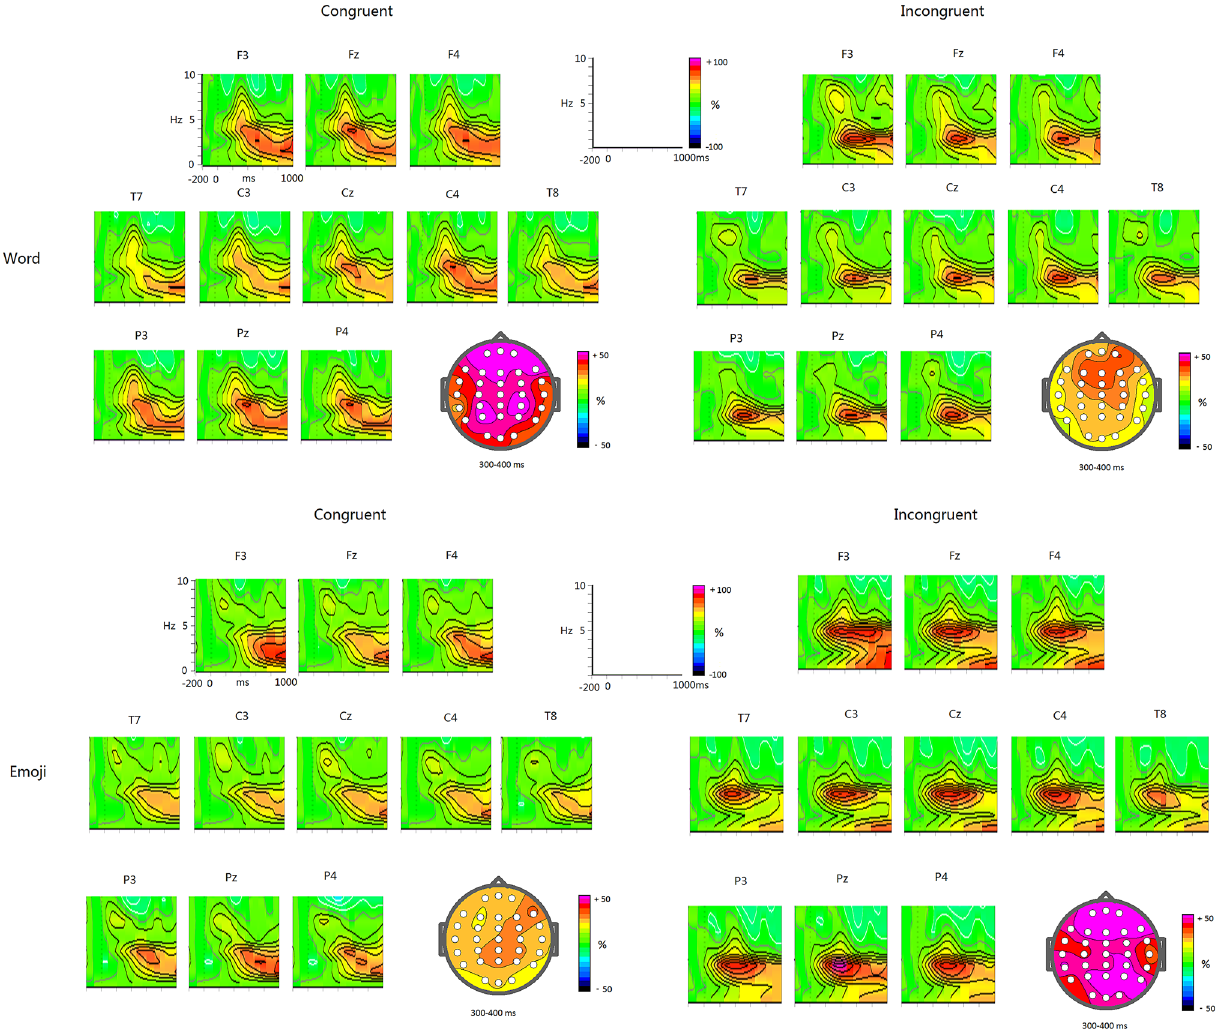
Figure 1. TBOs for word and emoji conditions as well as the 2D scalp mapping,